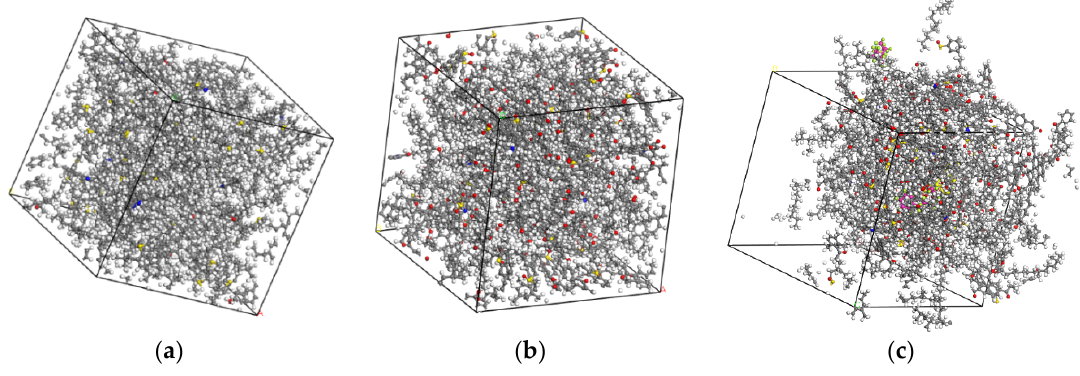
Figure 9. Asphalt molecular model. ( a ) BA. ( b ) Aged asphalt. ( c ) Rejuvenated asphalt.